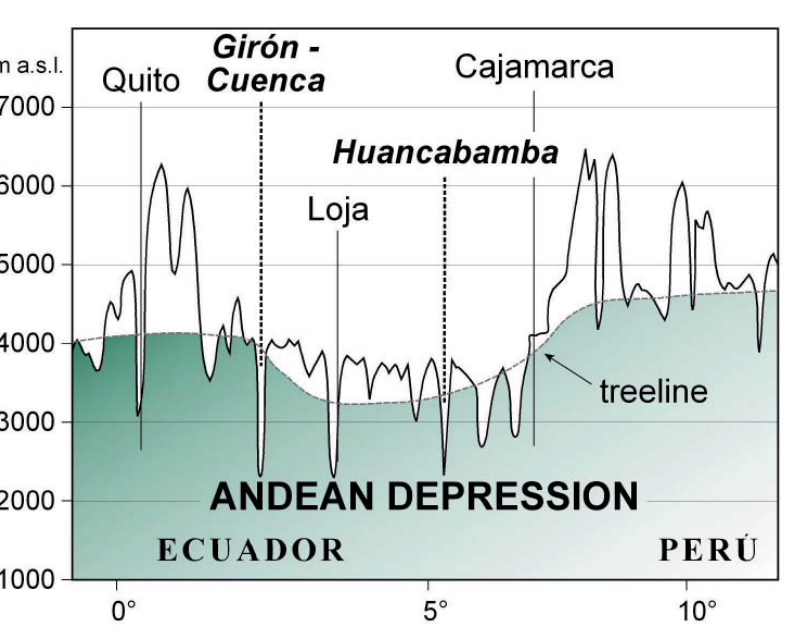
Figure 2: Position of the Andean Depression and its core zone around Huancabamba. The research area is located near the town of Loja. Note the treeline depression in this lower section of the